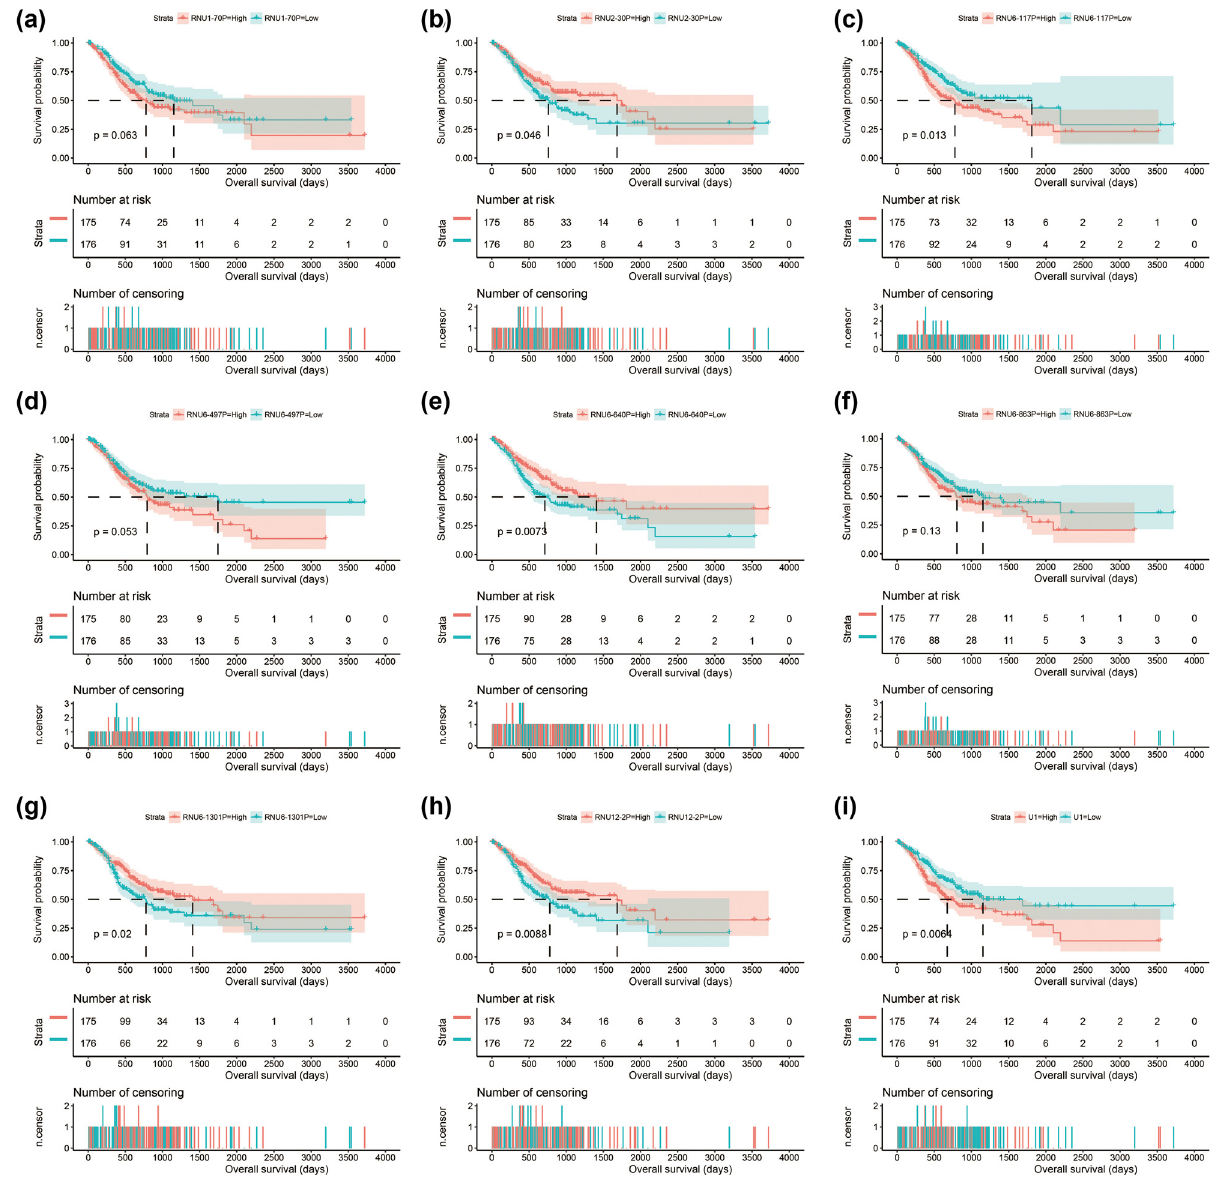
Figure 3: Kaplan – Meier curve of this prognostic signature containing nine snRNAs in GC: ( a ) RUN1 – 70P; ( b ) RUN2 – 30P; ( c ) RUN6 – 117P; ( d ) RUN6 – 497P; ( e ) RUN6 – 640P; ( f ) RUN6 – 863P; ( g ) RUN6 – 1301P; ( h ) RUN12 – 2P; and ( i )